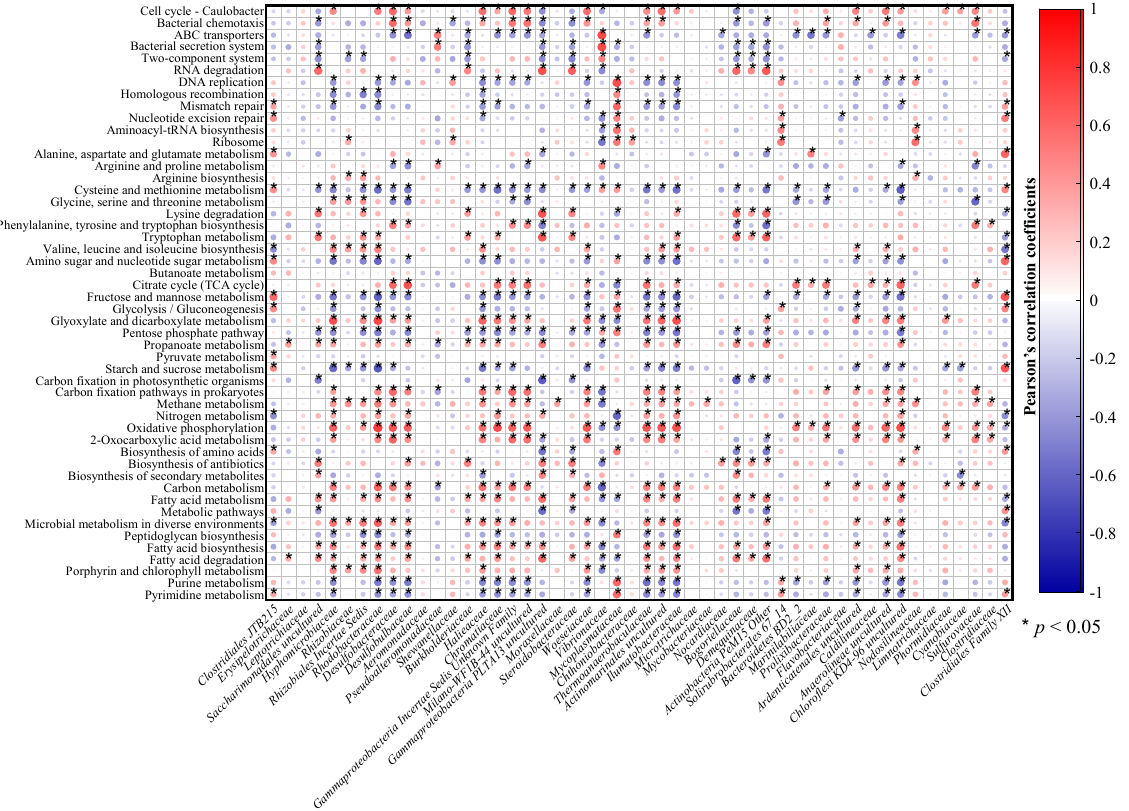
Figure 6. Correlations of intestinal bacteria (at the family level) and predicted gut microbial functions (relative abundances) based on Pearson’s correlation coefficients ( p < 0.05). The red circles represent a positive correlation, the blue circles represent a negative correlation, and the circle sizes reflect the absolute value of the correlation coefficient.